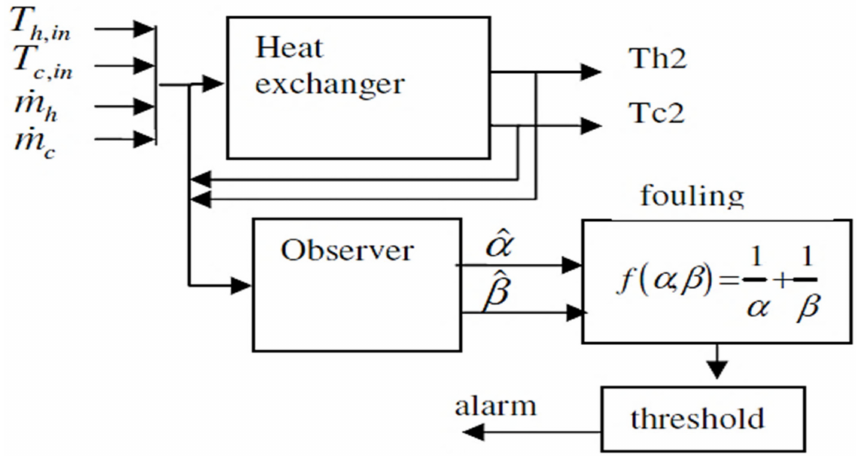
Figure 18. A nonlinear observer diagram